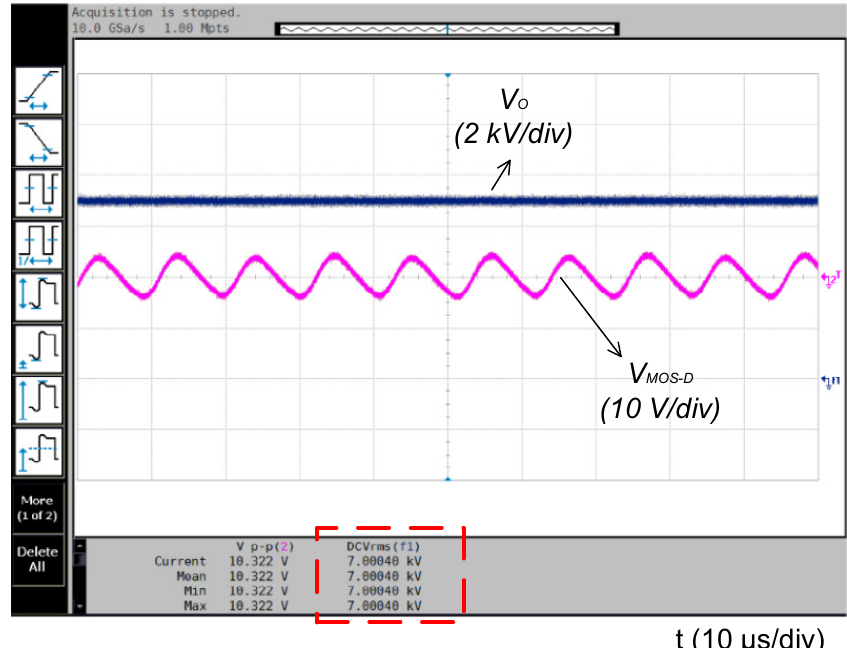
Figure 11. LDO input voltage ripple ( V MOS − D and test value of the output high voltage ( V o ). The test value of the output high voltage obtained by a digital multimeter is shown in Figure 12. The digital multimeter performs measurements with a 1000:1 probe, so the test value is 7.00011 V